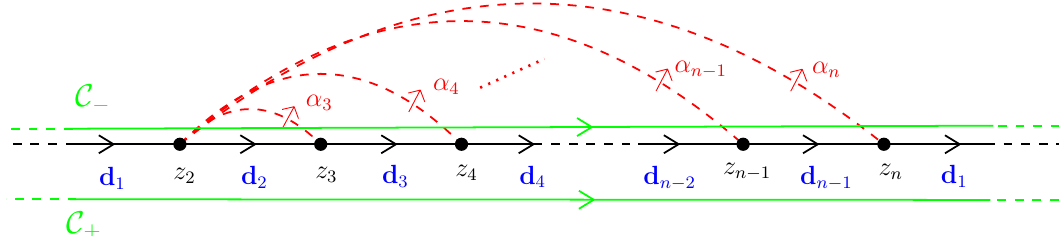
Figure 5. Contours producing boundary relations on the twisted homology. The left- and right- most ends of the horizontal contours are connected, since they are de(cid:12)ned on CP 1 . Using the fact that @(cid:13) = ( (cid:11) (cid:0) 1) a , and @(cid:26) = b (cid:0) a , it is immediate but instructive to check i i that its boundary, in the twisted sense, is